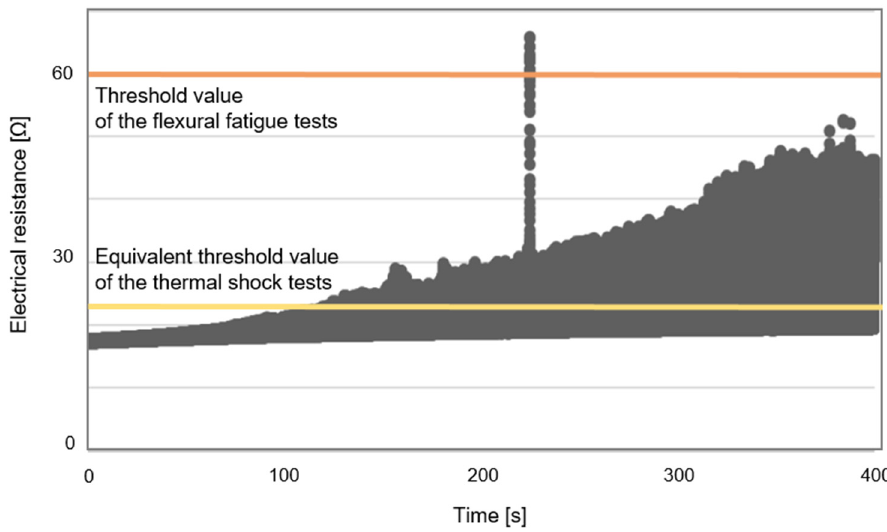
Figure 12. Determination of the threshold value for the flexural fatigue tests.